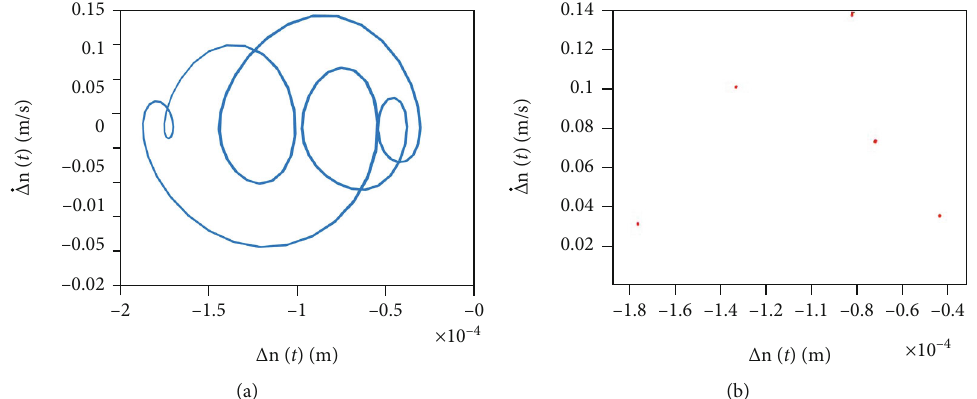
Figure 24: When the wear is 4 : 77 × 10 − 5 m (the misalignment in the x direction is 3 : 7 × 10 − 4 m): (a) relative displacement velocity and (b) the corresponding diagram of Poincare.